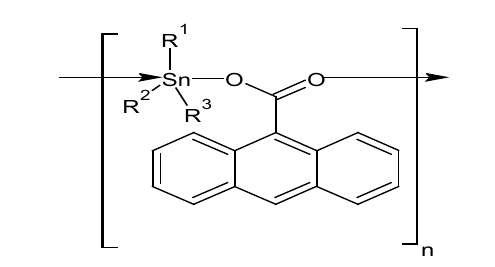
Figure 1. Polymeric structure of triorganotin carboxylates (R= Me, Bu,